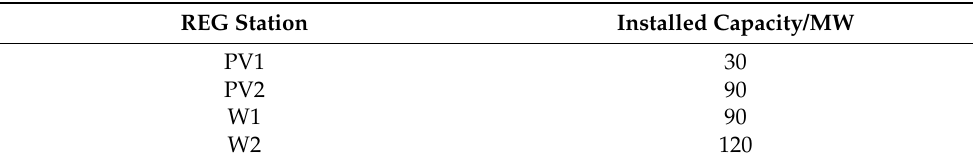
Table 1. Installed capacity of each new energy